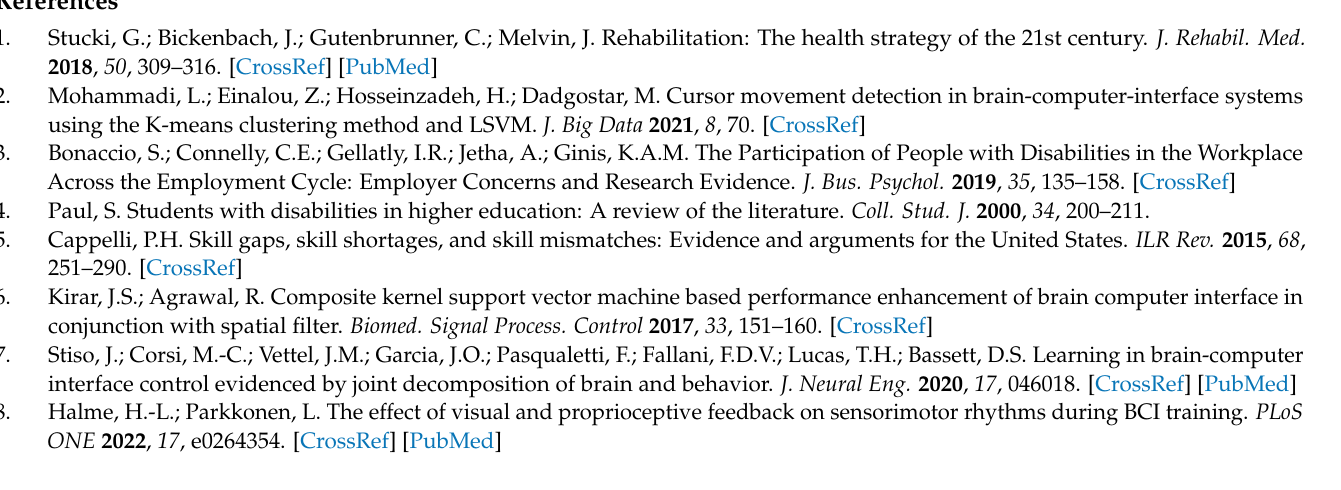
Figure S2: Data example with noise for one participant, sensor FP2. Orange: thoughts on right hand, Blue: thoughts on left hand. Figure S3: Data plot for second participant, sensor FP1. Orange: thoughts on right hand, Blue: thoughts on left hand. Figure S4: Data plot for second participant, sensor FP2. Orange: thoughts on right hand, Blue: thoughts on left hand. Figure S5: Data plot for second participant, sensor C4. Orange: thoughts on right hand, Blue: thoughts on left hand. Figure S6: Data plot for second participant, sensor P8. Orange: thoughts on right hand, Blue: thoughts on left hand. Figure S7: Data plot for second participant, sensor P7. Orange: thoughts on right hand, Blue: thoughts on left hand. Figure S8: Data plot for third participant, sensor FP1. Orange: thoughts on right hand, Blue: thoughts on left hand. Figure S9: Data plot for third participant, sensor FP2. Orange: thoughts on right hand, Blue: thoughts on left hand. Figure S10: Data plot for second participant, sensor C4. Orange: thoughts on right hand, Blue: thoughts on left hand. Figure S11: Data plot for second participant, sensor P7. Orange: thoughts on right hand, Blue: thoughts on left hand. Figure S12: Data plot for second participant, sensor P8. Orange: thoughts on right hand, Blue: thoughts on left hand. Figure S13: Data plot for forth participant, sensor FP1. Orange: thoughts on right hand, Blue: thoughts on left hand. Figure S14: Data plot for forth participant, sensor FP1. Orange: thoughts on right hand, Blue: thoughts on left hand. Figure S15: Data plot for forth participant, sensor C4. Orange: thoughts on right hand, Blue: thoughts on left hand. Figure S16: Data plot for second participant, sensor P7. Orange: thoughts on right hand, Blue: thoughts on left hand. Figure S17: Data plot for second participant, sensor P8. Orange: thoughts on right hand, Blue: thoughts on left